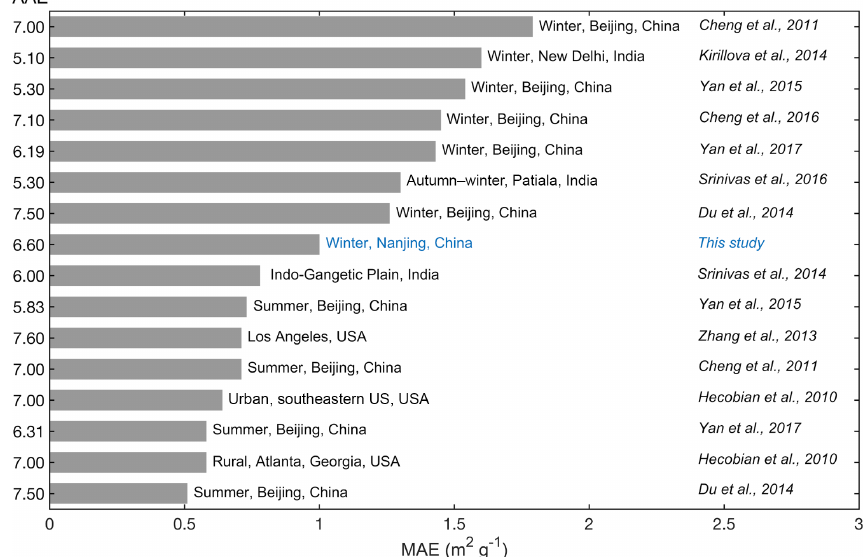
Figure 11. Comparison of mean mass absorbance efficiency (MAE) and absorption Ångström exponent (AAE) of WSOC in PM 2 . 5 in this study with those reported in the literature.